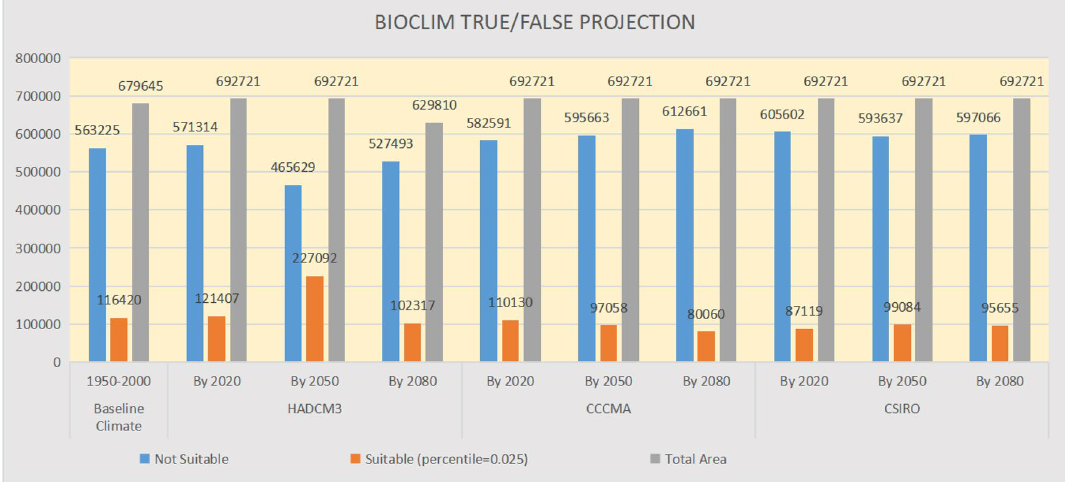
Fig. 8 Comparison of BIOCLIM True or False predicted ecological niches for malaria vectors’ habitats from current climate (1950–2000), HADCM3, CCCMA and CSIRO